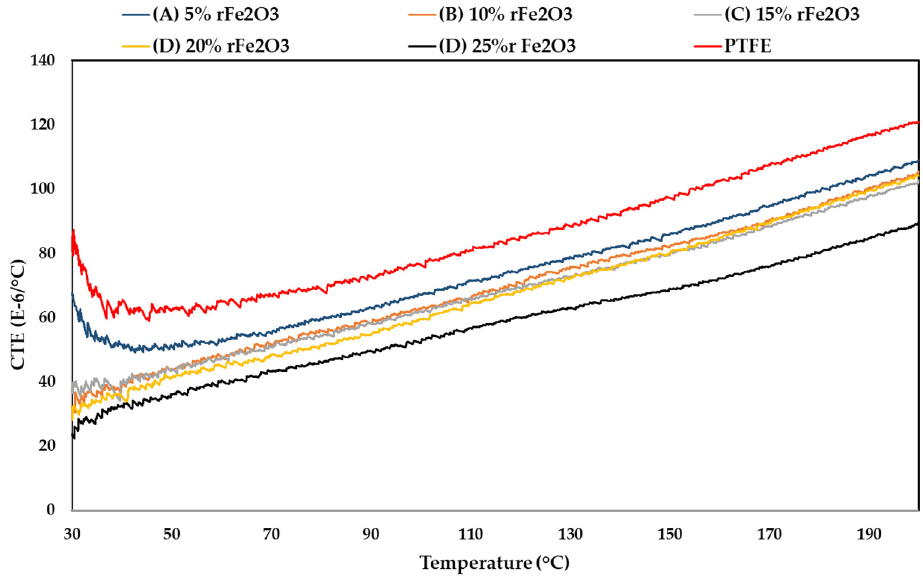
Figure 8. Thermal expansion coefficients of rFe 2 O 3 –PTFE nanocomposites.